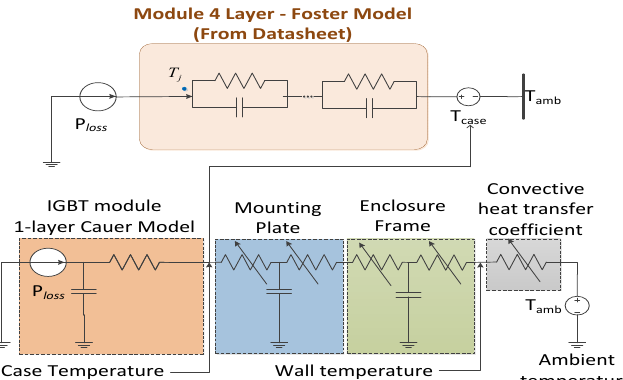
Figure 15. Thermal circuit for determining IGBT and diode junction temperatures in a passively cooled converter, from [5]. T j , shown in the figure, is the junction temperature of interest in the lifetime model used in this paper. This T j can correspond to either the junction temperature of the IGBT or the diode, depending on which 4-layer Foster network is used.